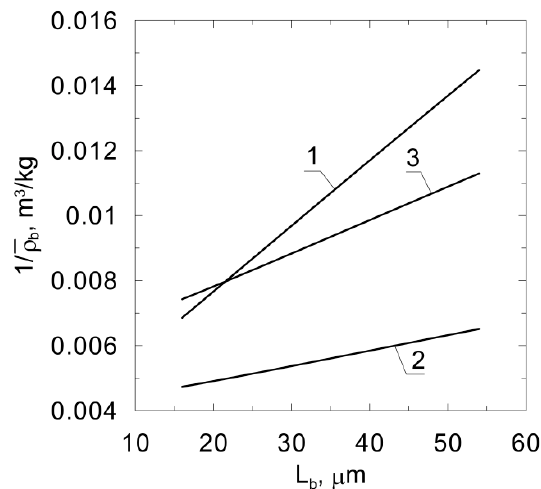
f L ρ = obtained based on experimental studies; line‘1’ [16,17]; = f ( L ) obtained based on experimental studies; line‘1’ [16,17]; line‘2’ [18]; b b b b